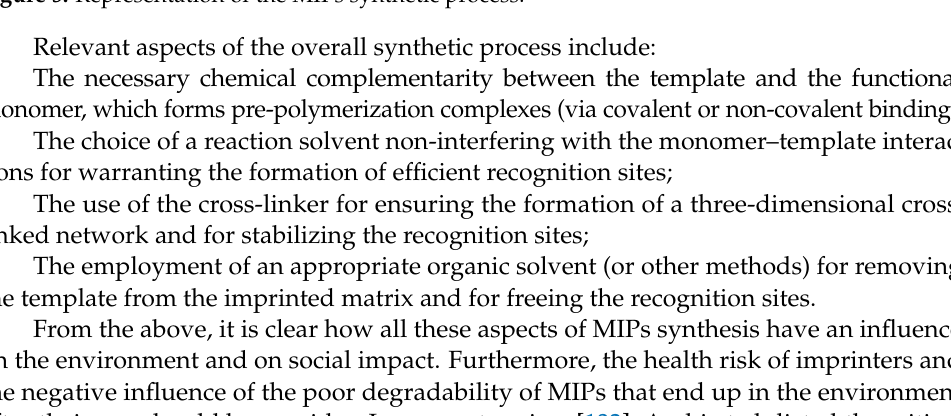
Figure 5. Representation of the MIPs synthetic